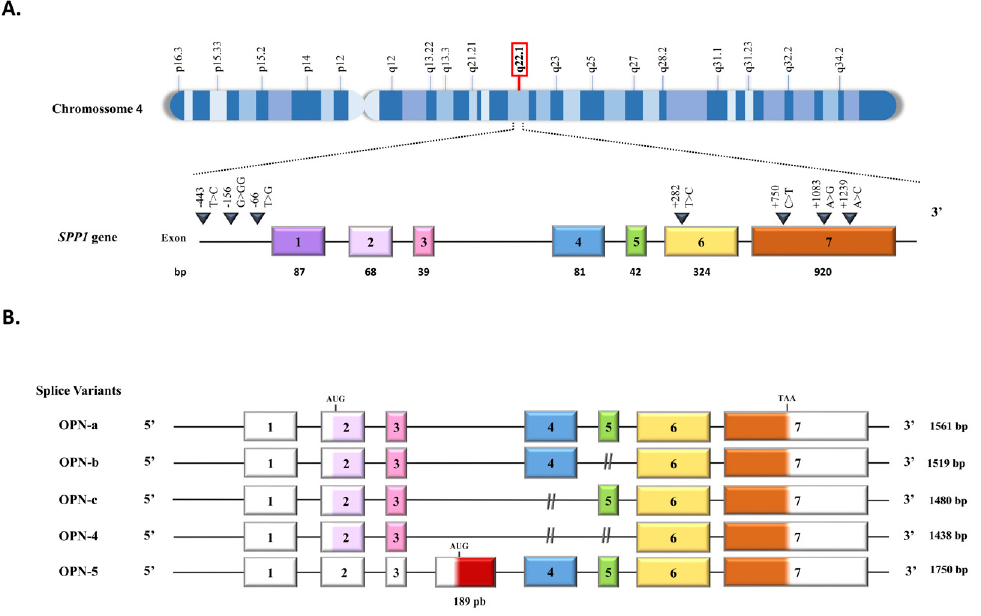
Figure 1. Schematic representation of the OPN gene and its transcripts. ( A ) OPN encoding gene located on human chromosome 4q22.1. The gene is 14,762 bp long and contains 7 exons. ( B ) OPN splice variants. The OPN primary transcript is processed by the alternative splicing resulting in at least five variants: OPN-a contains 7 exons and is known as the canonical isoform; OPN-b lacks exon 5 (green box); OPN-c lacks exon 4 (blue box); OPN-4 lacks both exon 4 and exon 5 (blue and green boxes); and OPN-5, which has an extra exon (red box), resulting from the retention of an intronic portion between exon 3 and exon 4, being the longest OPN splice variant. OPN-5 starts its translation at an alternative site located in the extra exon. ( C ) OPN-5 subvariants. OPN-5a is the OPN-5, as described above; OPN-5b has the extra truncated exon; OPN-5c has an additional 9 bp in the 3’ region in the extra exon (red box surrounded by a bolded black line); OPN-5d has an additional 9 bp in the 3’ region in the extra exon and deletion of exon 5; OPN-5e lacks exon 5. This Figure was partially based on information provided in previous reports [9,11,12]. OPN is a negatively charged protein due to the presence of multiple aspartate residues and displays a secondary structure with 8 α -helices and 6 β -sheets [13]. It is also an intrinsically disordered protein, displaying simultaneously sample extended, random coil-like conformations and stable, cooperatively folded conformations [14,15]. OPN displays several isoforms generated by alternative splicing [16], alternative translation, and post-translational mechanisms [17], such as serine/threonine phosphorylation, glycosylation, tyrosine sulfation, and proteolytic cleavage. These